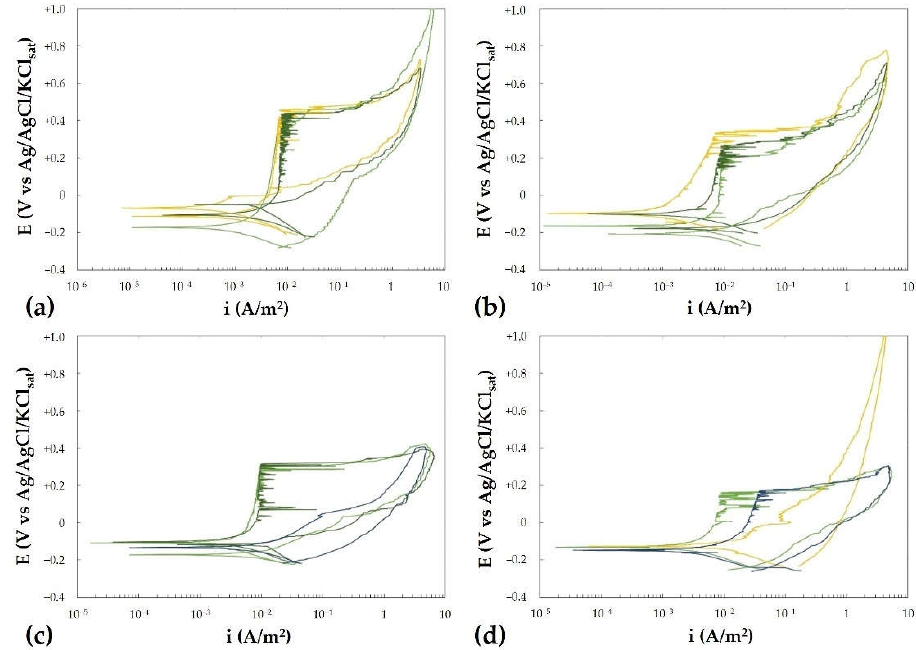
Figure 3. Potentiodynamic polarization curves of ( a ) AISI 430—ground finishing—100 ppm [Cl − ] - -cross-section; ( b ) AISI 430—drawn finishing -100 ppm [Cl − ]—cross-section; ( c ) AISI 430—ground finishing—1000 ppm [Cl − ]—cross-section; ( d ) AISI 430—drawn finishing—1000 ppm [Cl − ]—cross- section. The different colors of the lines in the graphs correspond to different specimens.